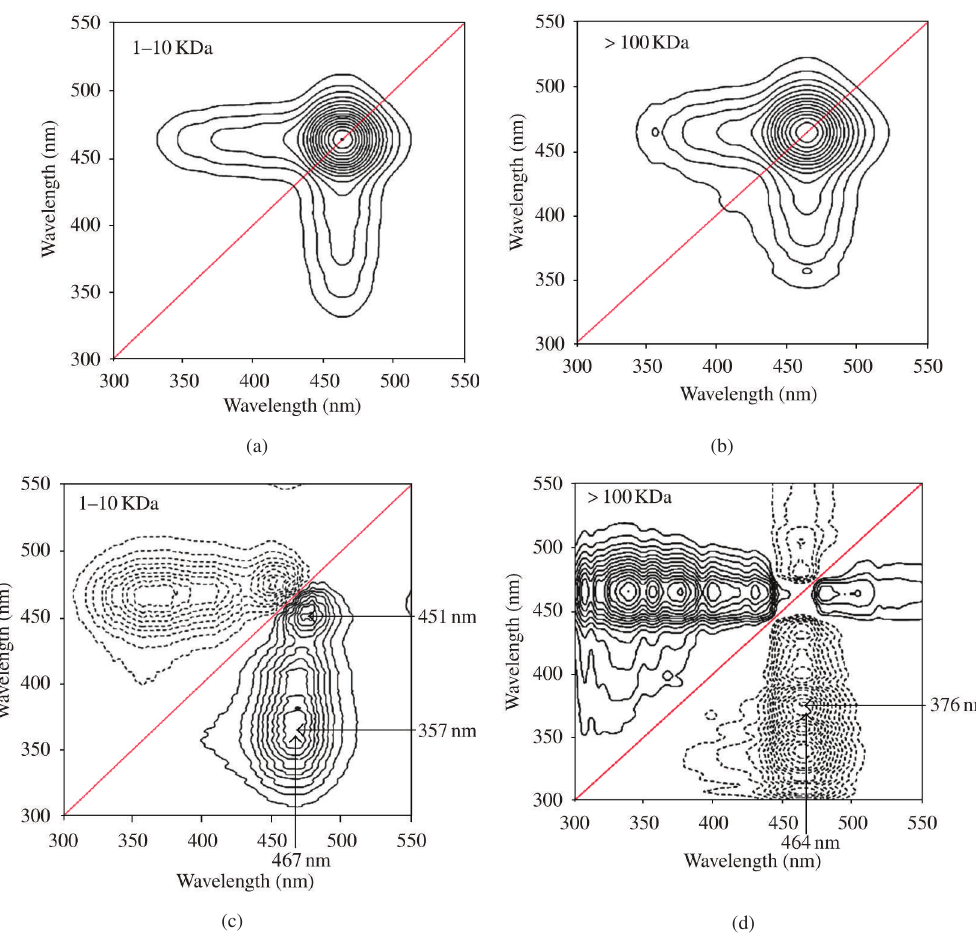
FIGURE 2: Synchronous 2D spectrum for (a) the 1–10 K fraction and (b) the > 100 K fraction. Asynchronous 2D spectrum for (c) the 1–10 K fraction and (d) the > 100 K fraction of the soil HA. The arrows indicate the main peaks of the spectra, based on which the copper-binding parameters were calculated in Table 2. The x - or y -axis represents the excitation wavelength of the synchronous fluorescence spectra. The solid and the dashed lines represent the positive and negative signs,